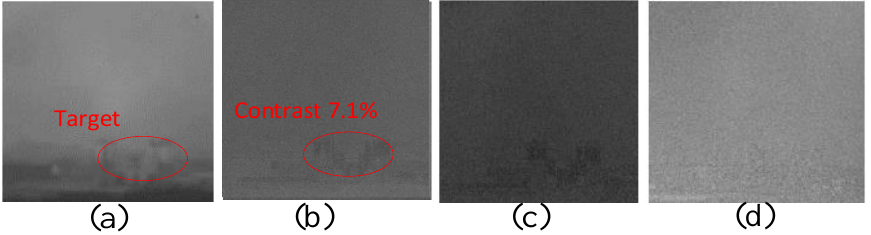
Figure 8. 450 nm band image ( a ) Intensity images ( b ) Polarization images ( c ) Line polarization im- ages ( d ) Polarization angle images.